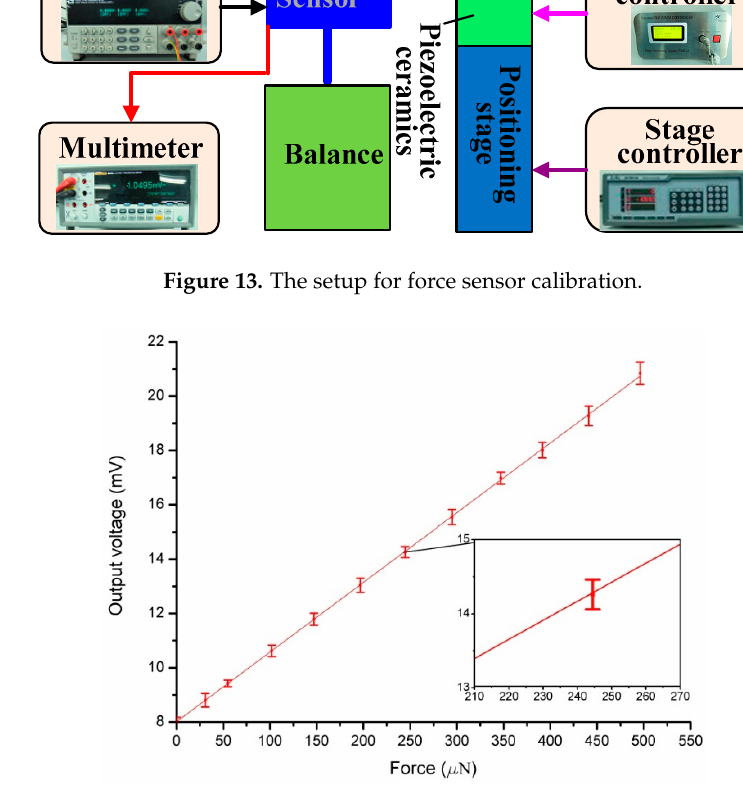
Figure 14. The output voltage of the micro-force sensor versus applied force. Table 1. Performance of the micro-force sensor.